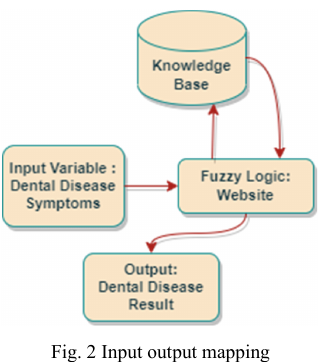
Fig. 2 Input output mapping